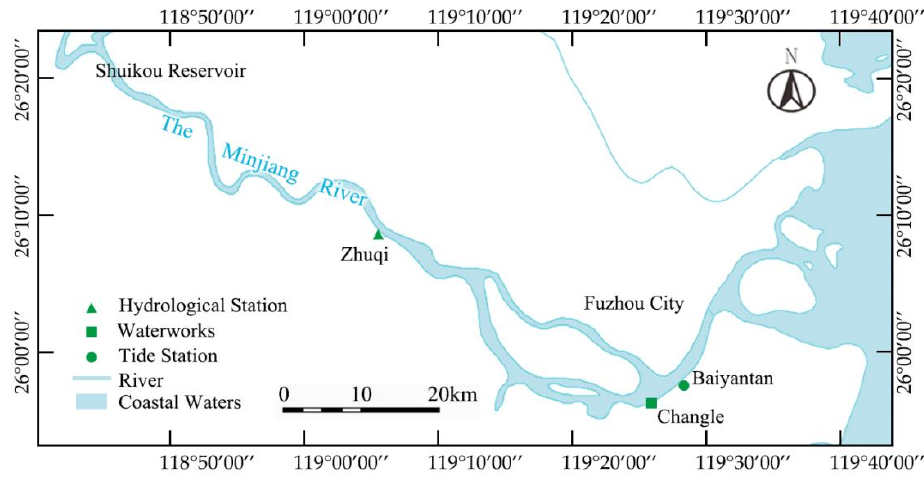
Figure 1. Overview of the study area.